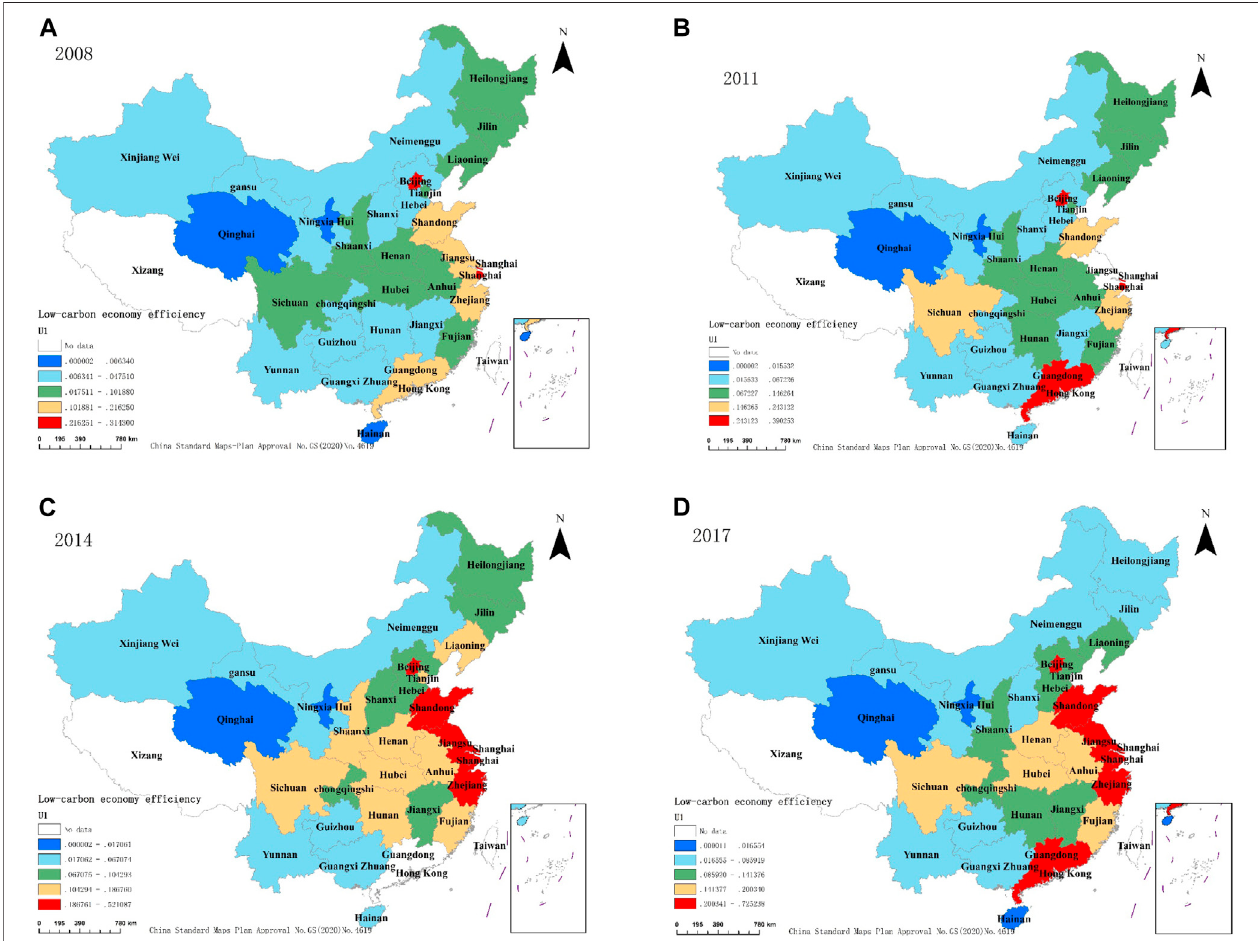
FIGURE 3 | Spatial distribution of the LCEE index. (A) China ’ s provincial LCEE in 2008; (B) China ’ s provincial LCEE in 2011; (C) China ’ s provincial LCEE in 2014; (D) China ’ s provincial LCEE in 2017.